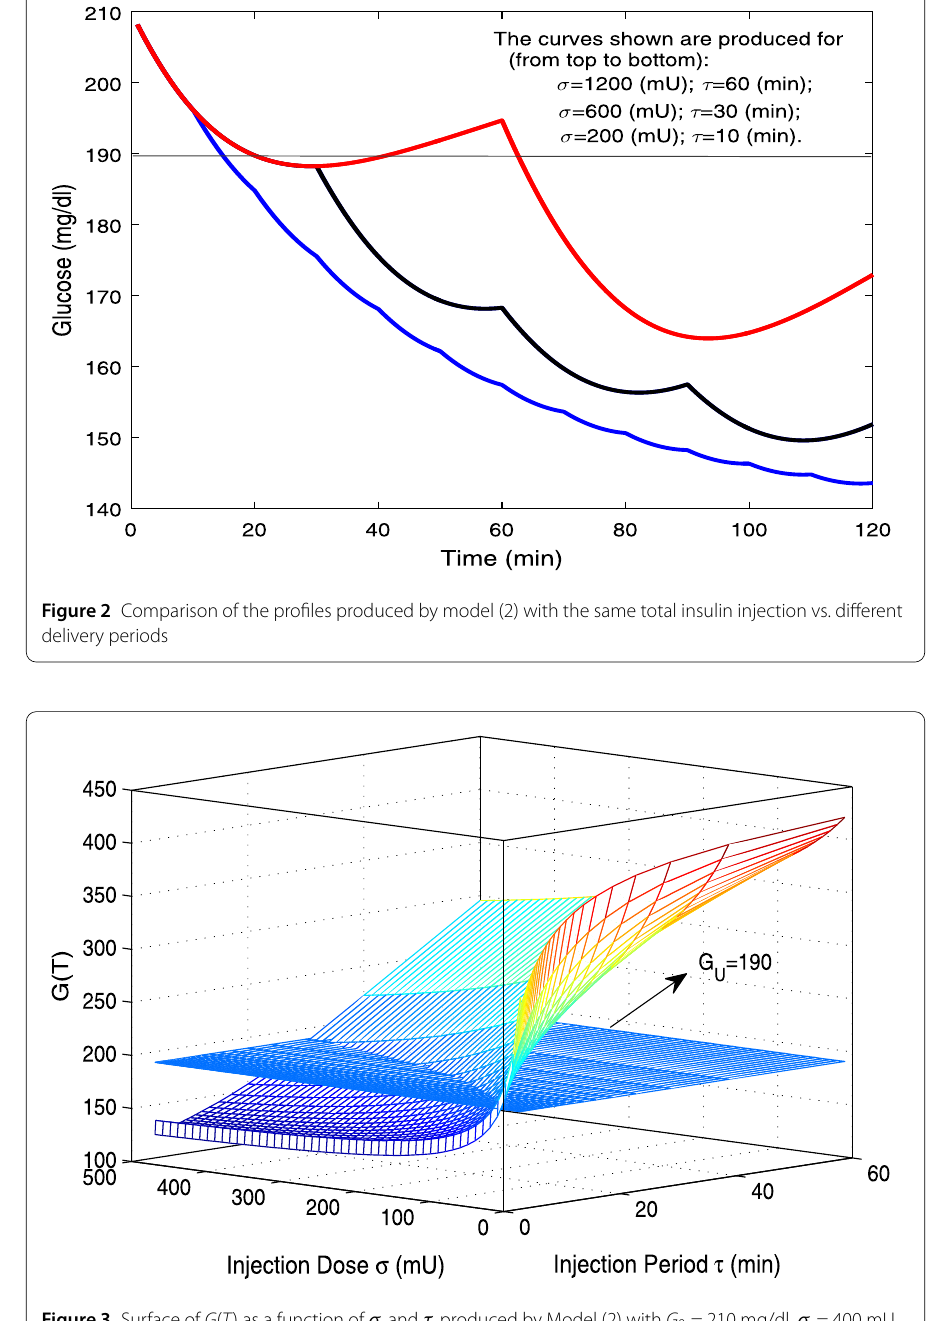
respectively. The simulation implies that, for fixed τ , G ( T ) decreases with increasing σ . For different τ , the control effect is better when the insulin injections are more frequent. Figure 5 confirms that, for fixed injection dose, the glucose level at time T becomes higher when the injection period τ becomes